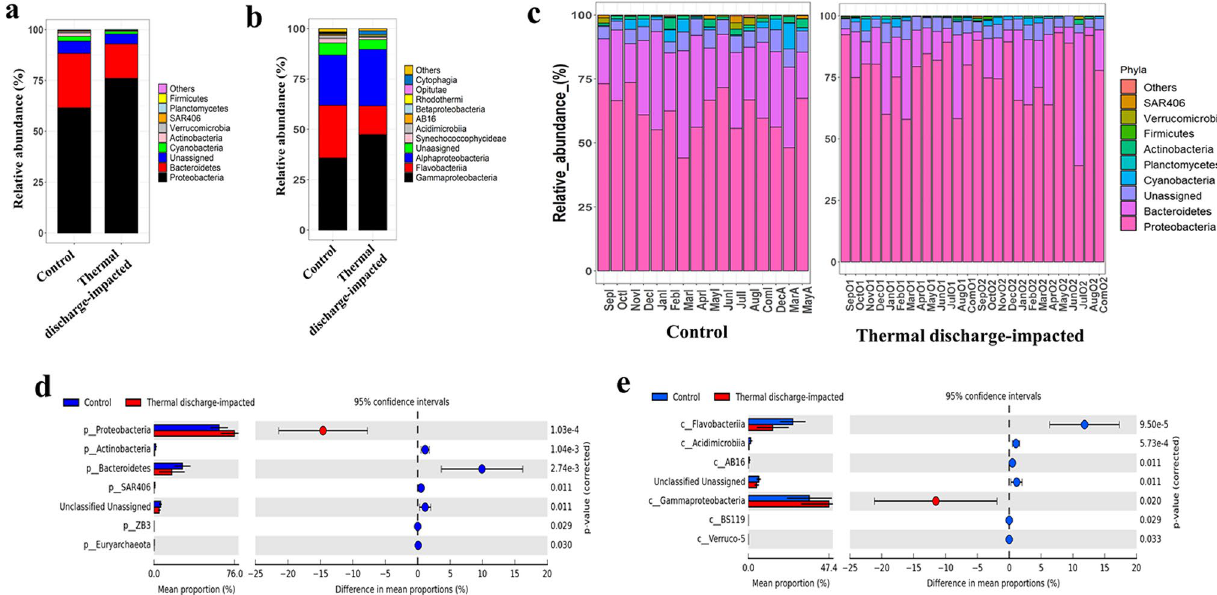
Figure 2. Taxonomic composition of top bacterioplankton groups. ( a , b ) Stacked bar plots depicting the average relative abundance of dominant bacterioplankton taxa at ( a ) phylum and ( b ) class levels in control (n = 16) and thermal discharge-impacted (n = 26) sample groups. ( c ) Month-wise relative abundance of bacterioplankton community. ( d , e ) Extended error bars displaying the variation in proportion of sequences of significantly differed bacterioplankton groups between control and thermal discharge-impacted areas at ( d ) phylum and ( e ) class level. Only those taxonomic groups are represented whose abundances constituted ≥ 0.5% of the total